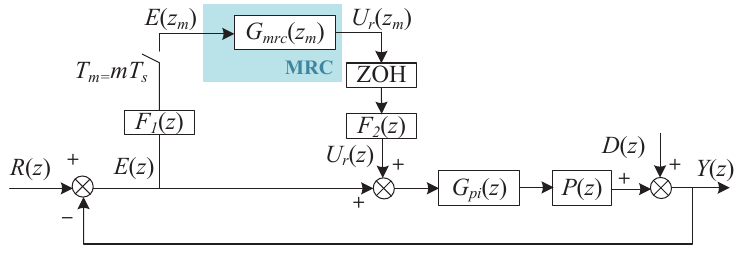
Figure 1. Plug-in MRC system.